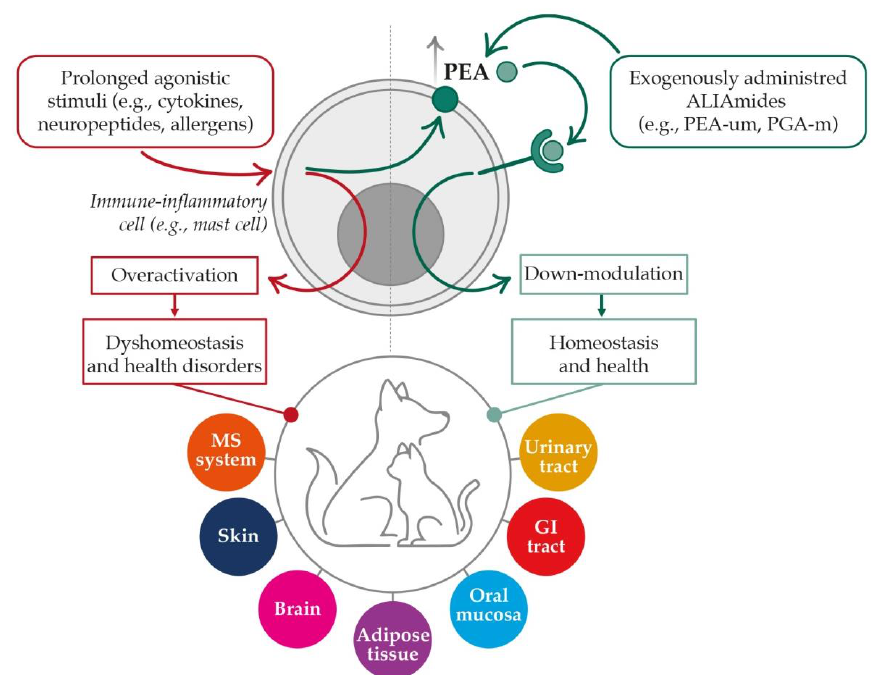
Figure 4. ALIAmides for small animal health—a global view. Upon prolonged stimulation, immune-inflammatory cells may become overactivated. If uncontrolled, their beneficial protective responses may instead turn harmful, leading to local dyshomeostasis and health disorders. In order to control the risk, autoprotective mechanisms are activated. The local production of PEA starting from a glycerophospholipid precursor (dark green circle) represents one of them. Once produced, PEA (light green circle) serves as a signaling molecule through its direct and indirect interactions with multiple receptor targets resulting in cell down-modulation. Local homeostasis and body health are maintained accordingly. Exogenously administered ALIAmides mimic or sustain the au- toprotective mechanism described above, mainly through restoring endogenous PEA levels. The main organs and body tissues purportedly benefiting from the aforementioned mechanism are listed in the colored circles on the bottom. GI = gastrointestinal, MS = musculoskeletal, PEA-um = ultramicronized palmitoylethanolamide, PGA-m = micronized palmitoylglucosamine. 6. Conclusions Although the field is still in its infancy, the studies presented in this review highlight the promise that ALIAmides might play a broad role in small animal health. Their physi- ological prohomeostatic functions represent a key rationale for their use in promoting